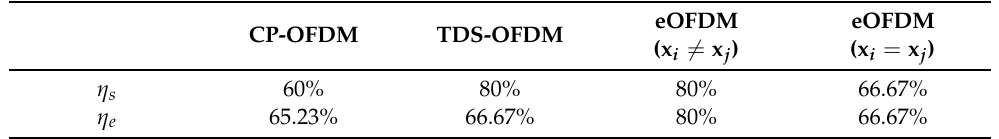
Table 2. Comparison of η s and η e for m = N